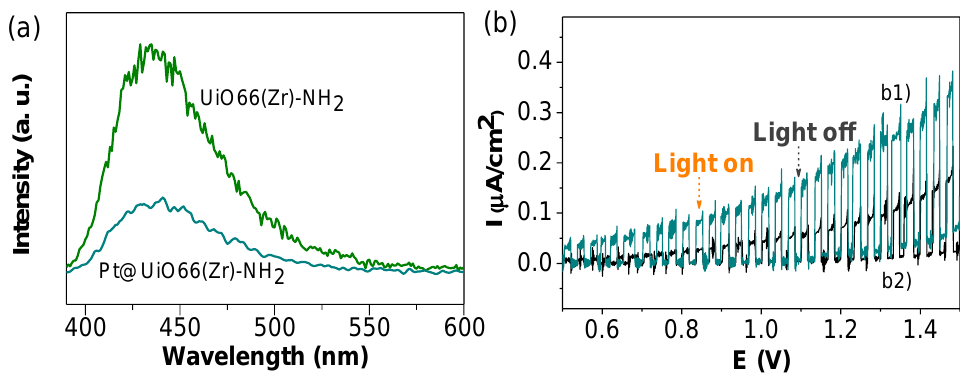
Figure 10. ( a ) PL of UiO-66(Zr)-NH 2 and Pt@UiO-66(Zr)-NH 2 upon excitation at 340 nm. ( b ) Photocurrent measurements upon electrode polarization and illumination/dark cycles using Pt@UiO-66(Zr)-NH 2 /FTO as the working electrode in the presence (b1) and absence (b2) of glycerol. TAS was also used to further study the reaction mechanism when using UiO-66(Zr)-NH 2 or Pt@UiO-66(Zr)-NH 2 as photocatalysts. Specifically, TAS spectrum of